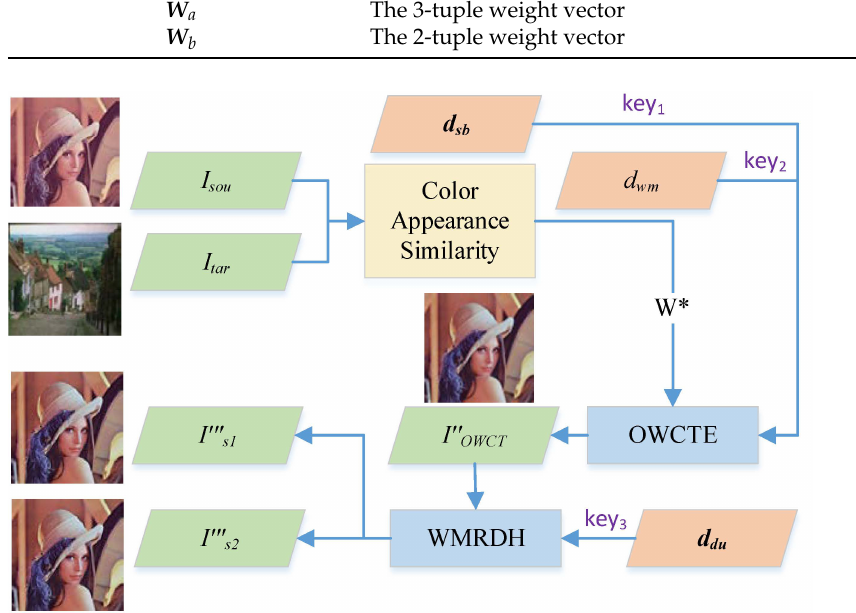
Figure 1. The flowchart of the message embedding in our proposed